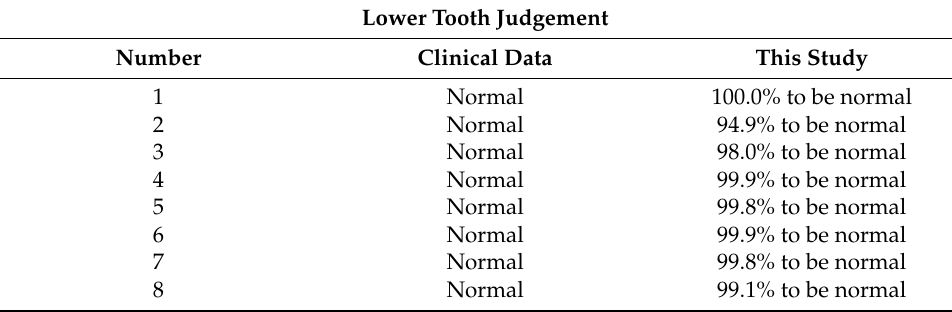
Table 5. Lower tooth judgement for the image in Figure